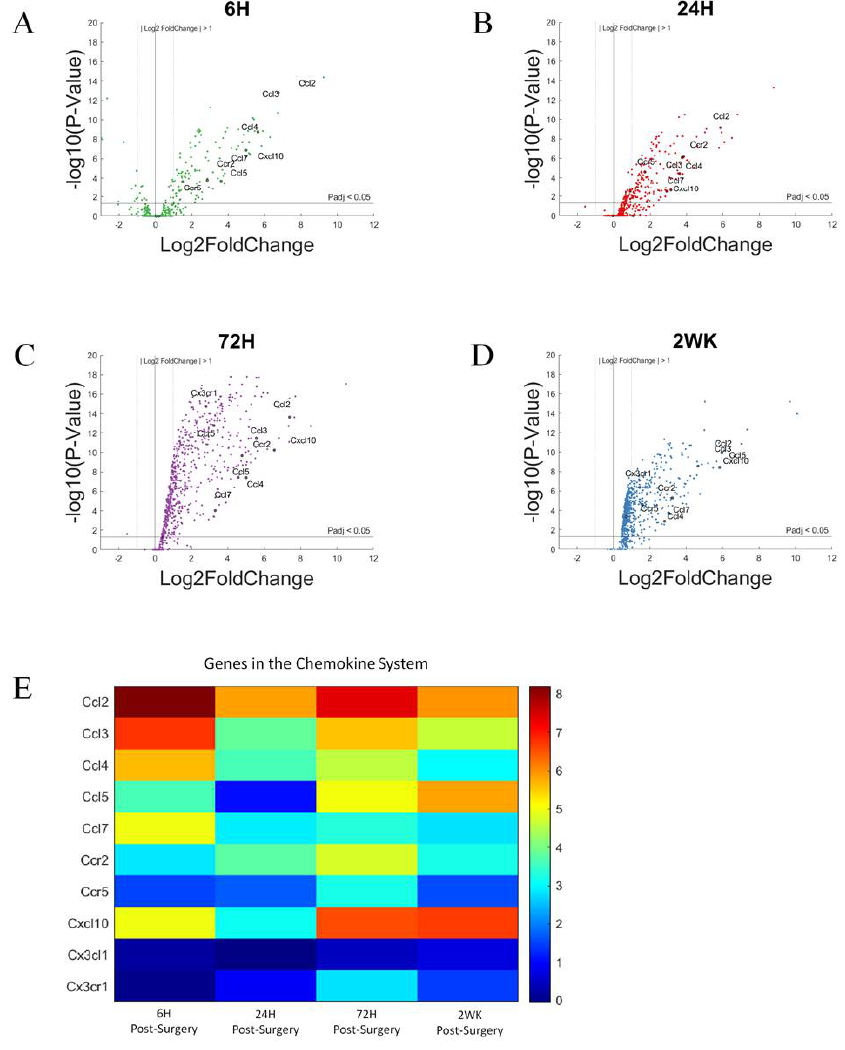
Figure 11. Differential expression of gene set involved in chemokine response compared to NSCTR mice: ( A – D ) volcano plot with genes in the chemokine system in black. Genes in the chemokine response system with P adj < 0.05 and log2foldchange > 1 or < − 1 are labeled. Each time point post- surgery is on a separate volcano plot. ( A ) =6-h, ( B ) =24-h, ( C ) =72-h, and ( D ) =2-weeks. Color in ( A – D ) corresponds to time post-surgery color coding in other figures. ( E ) heatmap showing differential expressions of genes of the chemokine system at each time point post-surgery compared to